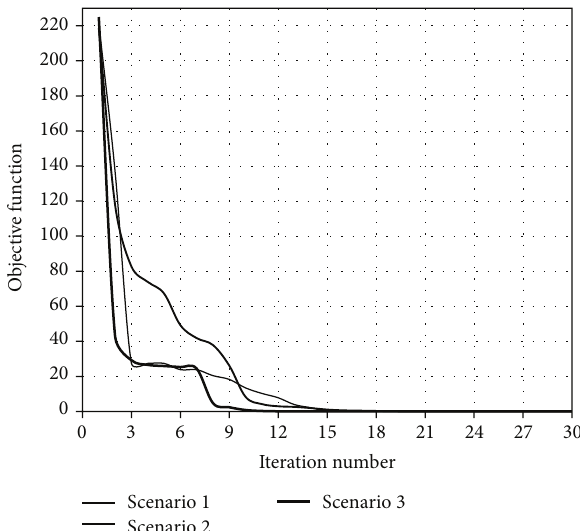
Figure 20: Convergence history for the three scenarios of the benchmark